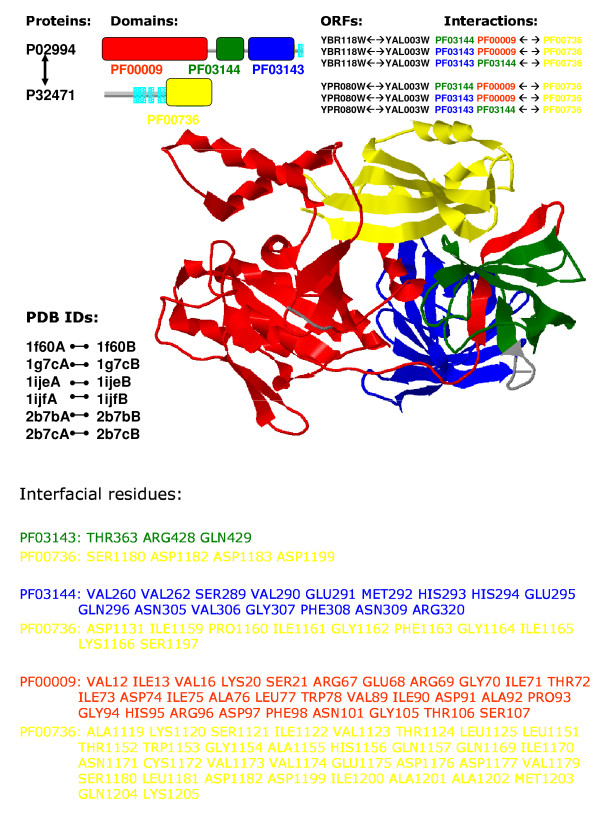
Cooperative domains in the complex crystal structure formed by proteins P02994 (with ORFs: YBR118W, YPR080W) and P32471 (with ORF: YAL003W). Protein sequences are shown using thick gray lines, and Pfam domain annotations are shown using colored rectangular boxes and drawn to scale (based on the Pfam database). The names of the protein sequences in this protein complex are listed to the upper left of the domain architecture. The identified cooperative domain pairs are listed to the upper right of the domain architecture. The domain names are labeled by the same color as in the Pfam domain annotation. The cartoon of PDB crystal structure (PDB ID: 1f60, Crystal structure of the yeast elongation factor complex) demonstrates the cooperative domain interactions (where domain colors are consistent with the domain annotation), i.e. domain PF00736 in protein P32471 interacts physically with domains of protein P02994. Other complexes in PDB containing these cooperative domains are also listed by their matched PDB IDs and chain IDs.